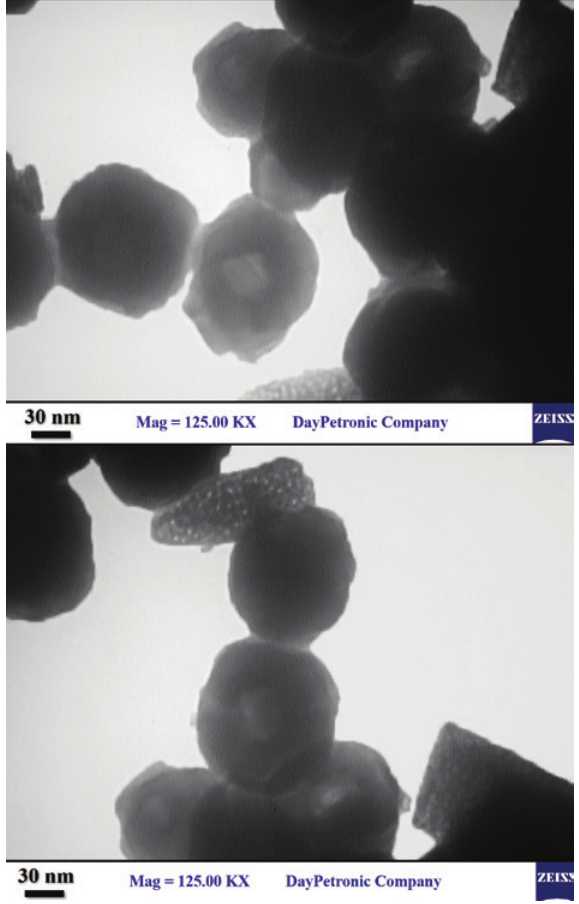
Figure 5: TEM images of cobalt-doped PbS obtained in the presence of